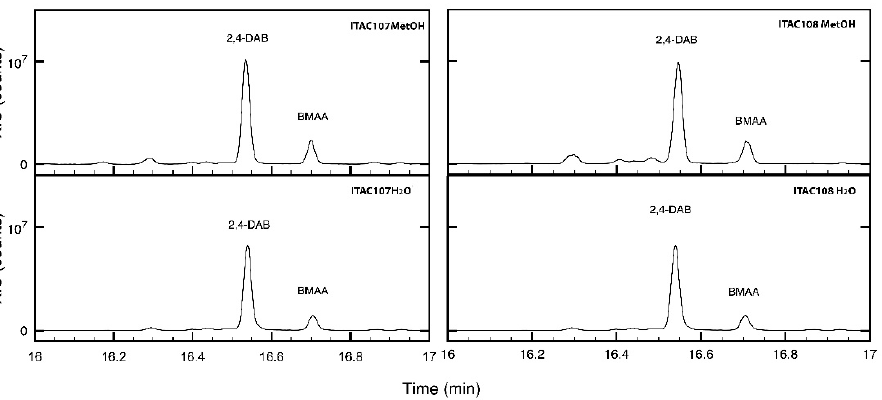
Figure 6. Extracted chromatograms of m/z 291.1263 ion for methanolic and aqueous extracts for Cyanobium sp. ITAC108 and Synechococcus sp. ITAC107 in the region comprised between 16 and 17 min. In the chromatograms, it is possible to identify 2,4-DAB and BMAA.